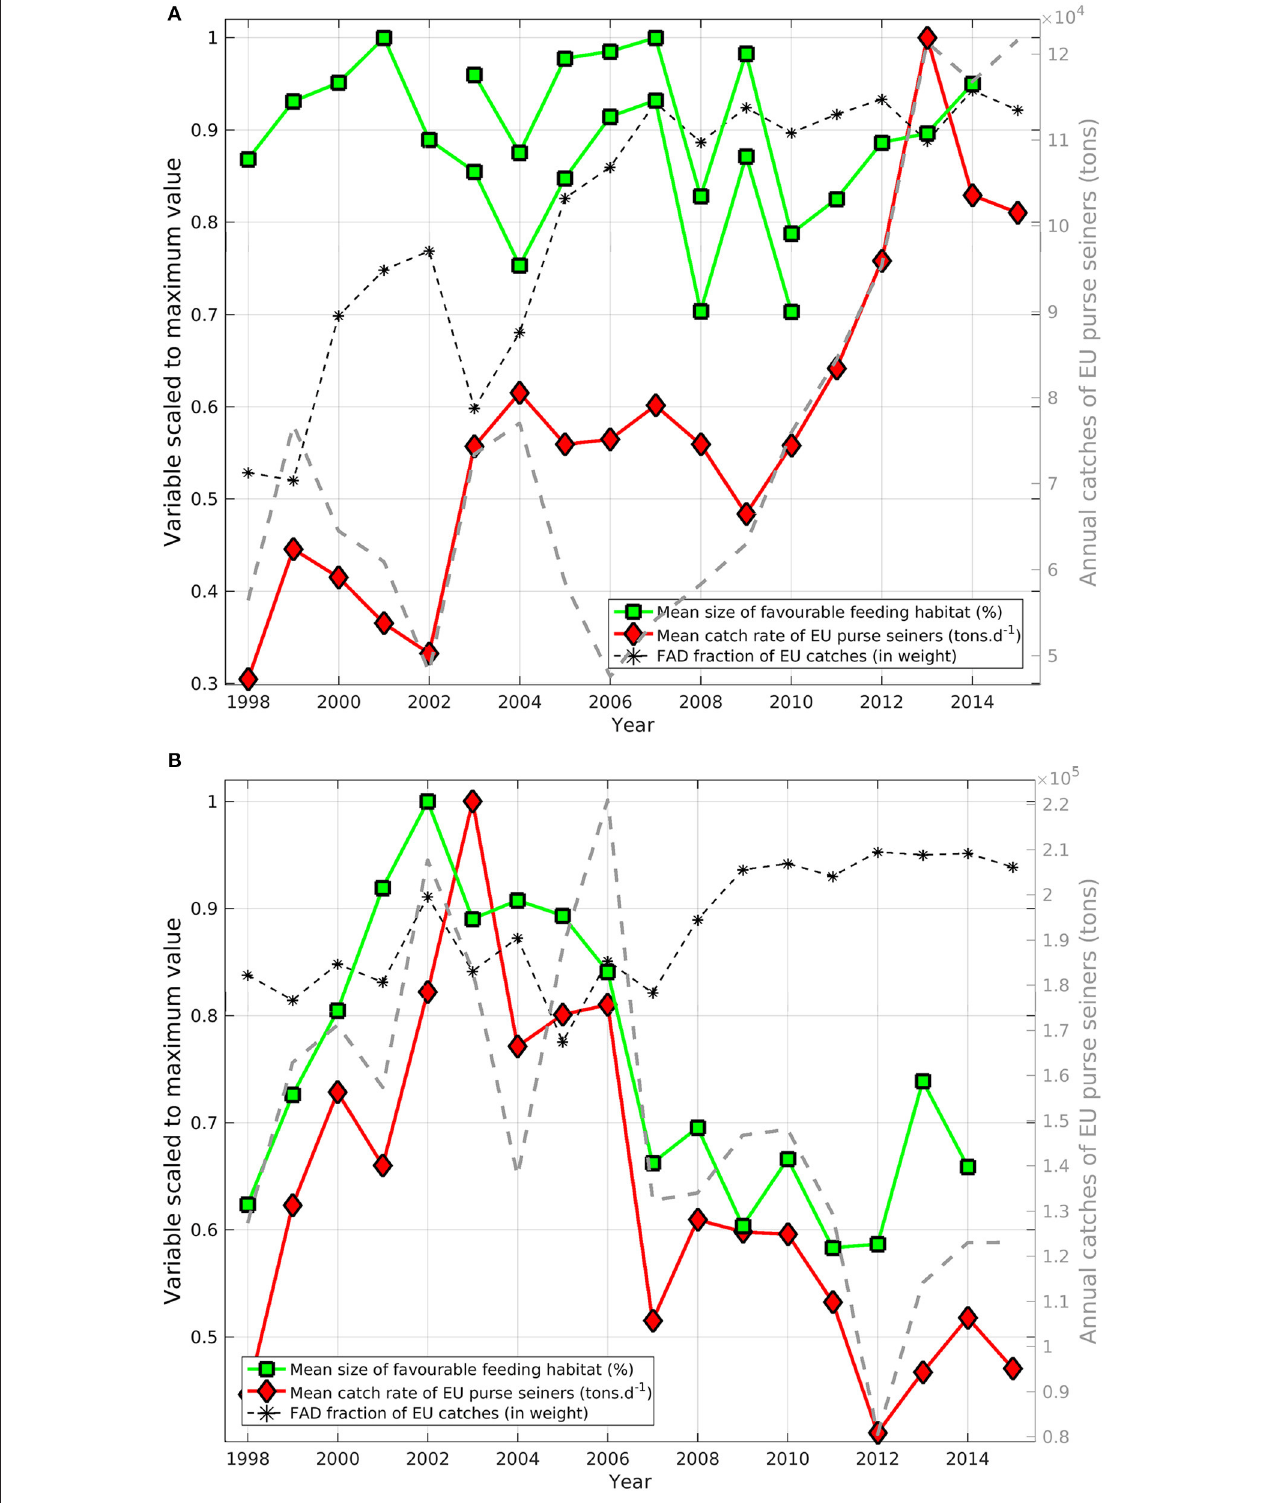
FIGURE 6 | Annual indices of habitat size (green squares) and catch rate (red diamonds) of skipjack tuna ( Katsuwonus pelamis ; SKJ) scaled to the maximum values in the time-series of total catches (dashed gray line, tons, right axis) in (A) the Eastern Central Atlantic Ocean and (B) the Western Indian Ocean. The proportion of dFAD catches (in weight; black stars) is overlaid (%, left axis). To avoid issues associated with cloud coverage, two independent time-series of annual favorable feeding habitat size were derived for the Atlantic using SeaWiFS (1998–2010) and MODIS-Aqua (2003–2014) data.